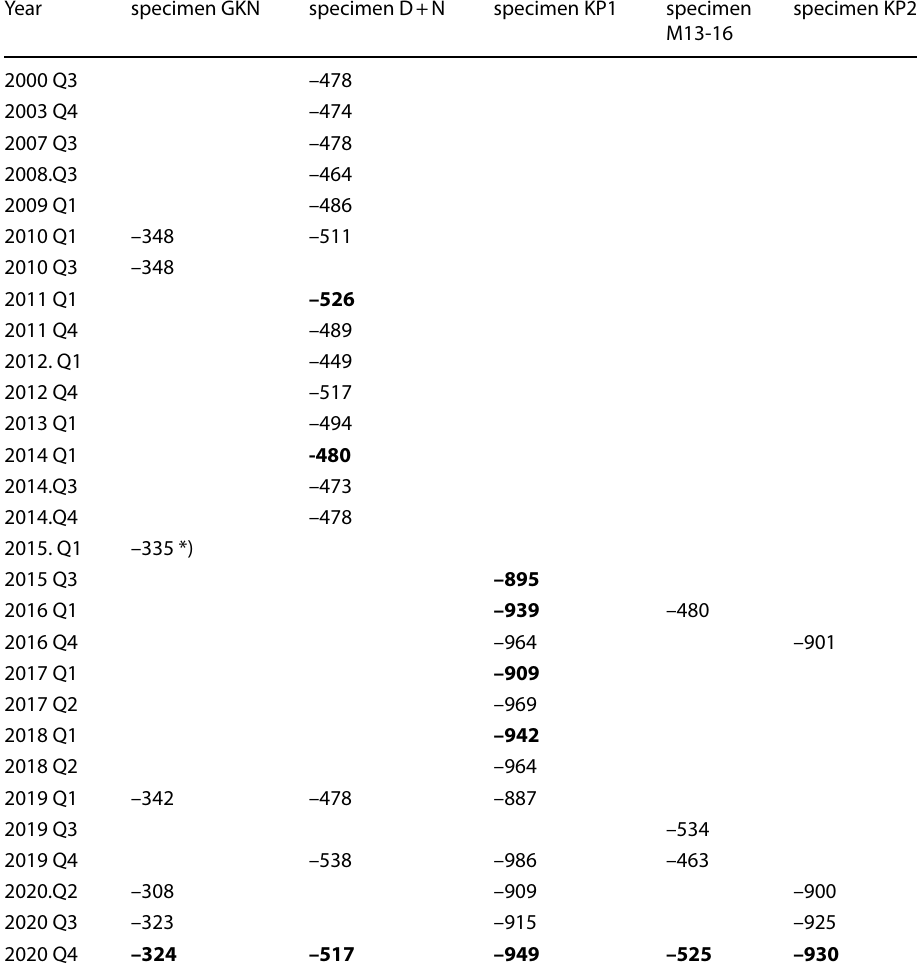
Bold values are a mean value of at least two different diffractometers. *Measured in